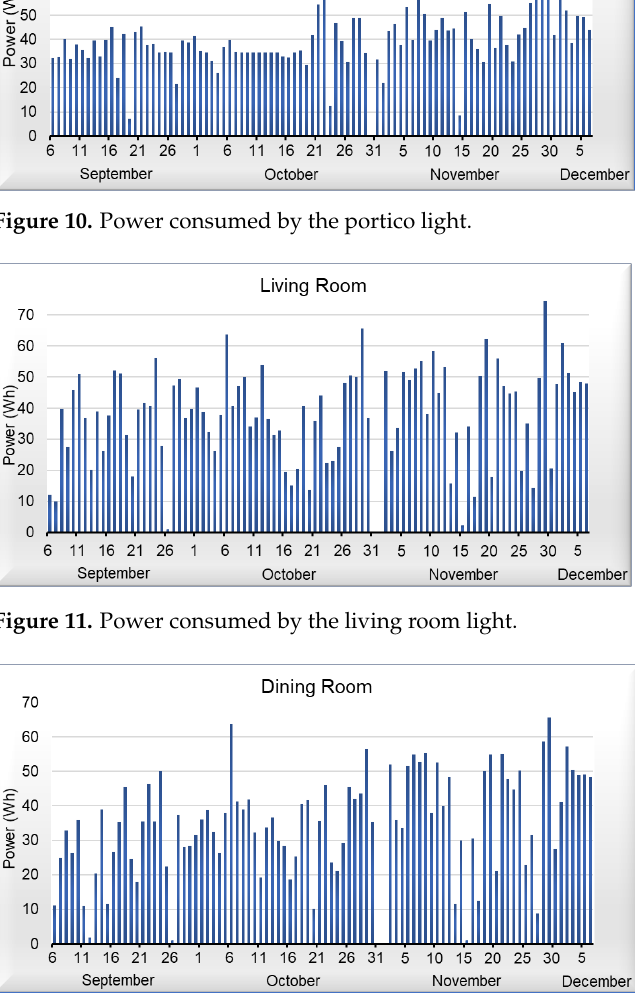
Figure 12. Power consumed by the dining room